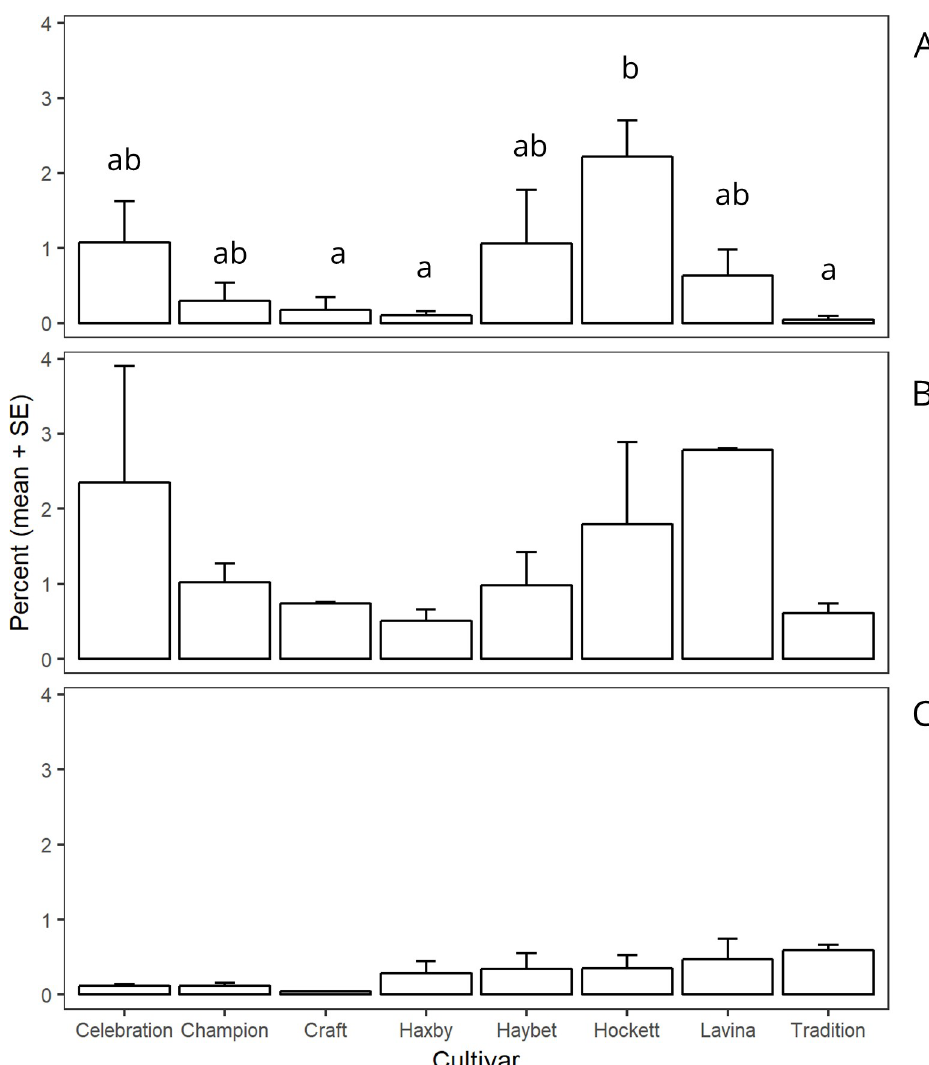
Fig 5. Mean percentages of irreplaceable mortality due to parasitism by site and cultivar. Bars within the site followed by different letters are significantly different ( α = 0.05) and the bars without letters within the site are not different ( α = 0.05). Panel A: Amsterdam 2016 (F 7,14 = 3.96, P = 0.013); Panel B: Amsterdam 2017 (F 7,7 = 2.30, P = 0.146); Panel C: Big Sandy 2017 (F 7,14 = 1.86, P = 0.152). SE is standard error of the mean.